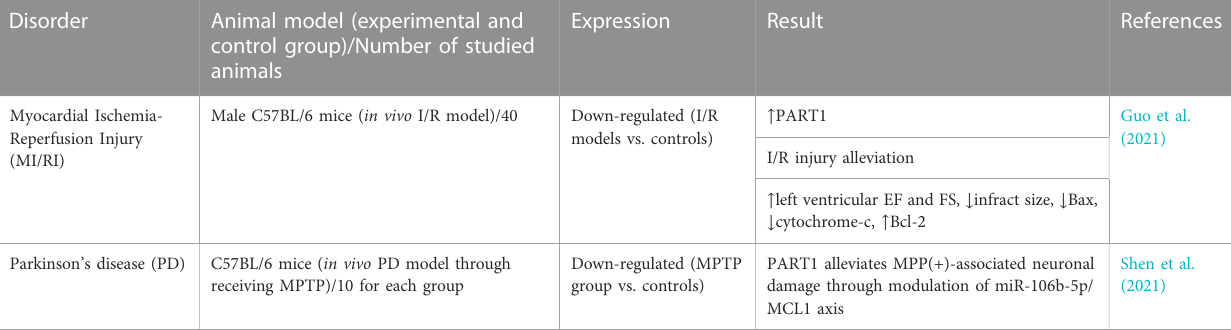
TABLE 9 Animal studies on the involvement of PART1 in non-malignant disorders (MPTP: methyl-4-phenyl-1, 2, 3, 6-tetrahydropyridine hydrochloride, I/R: Ischemia-Reperfusion, EF: ejection fraction, FS: fraction shortening, ↑ : increase, ↓ : decrease).